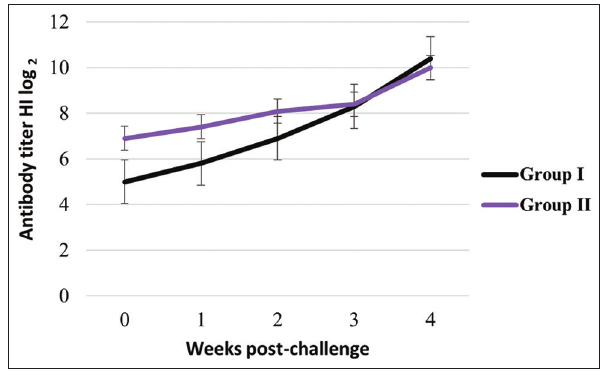
Figure-5: Dynamic of Newcastle disease virus hemagglutination inhibition titer antibody post-challenge. Group I was vaccinated with inactivated vaccine Gianyar-1/ AK/2014 and Group II with LaSota life vaccine.